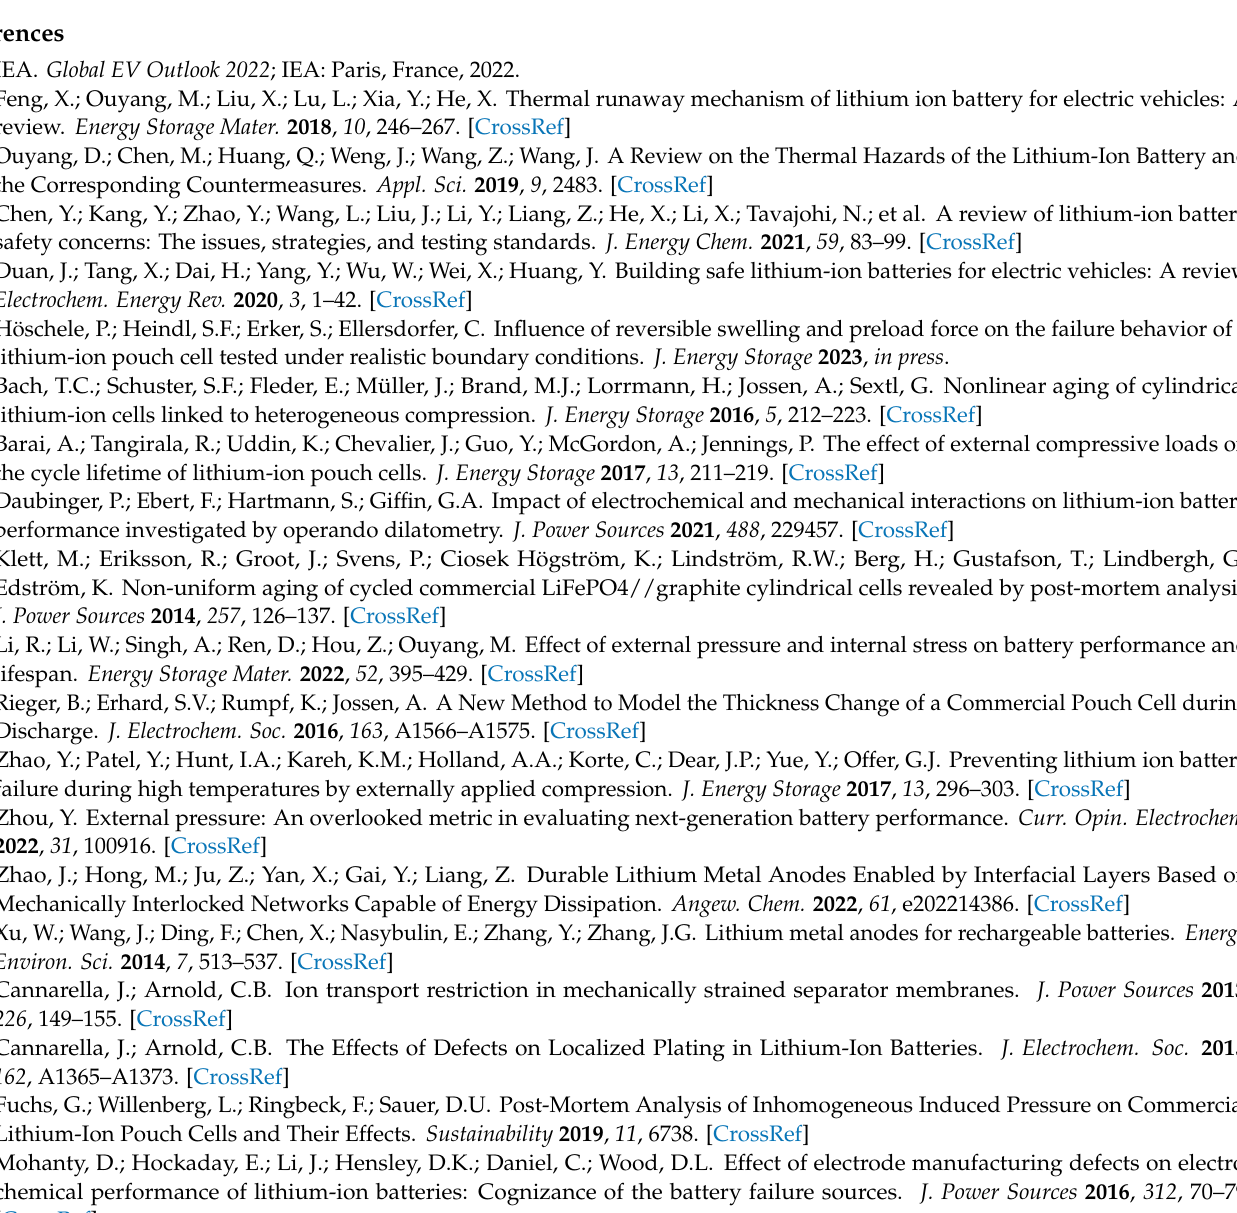
Figure A2. Pressure distribution MPa of the two fresh reference cells F1 and F2 at 0% and 100% SOC. ( a ) F1 and F pre = 300 N. ( b ) F2 and F pre = 300 N. ( c ) F1 and F pre = 4000 N. ( d ) F2 and F pre = 4000